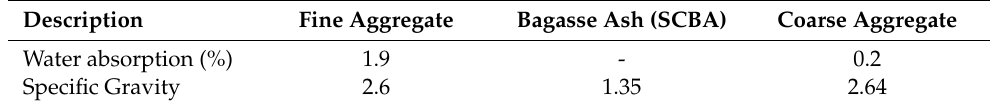
Table 1. Raw materials characteristics.